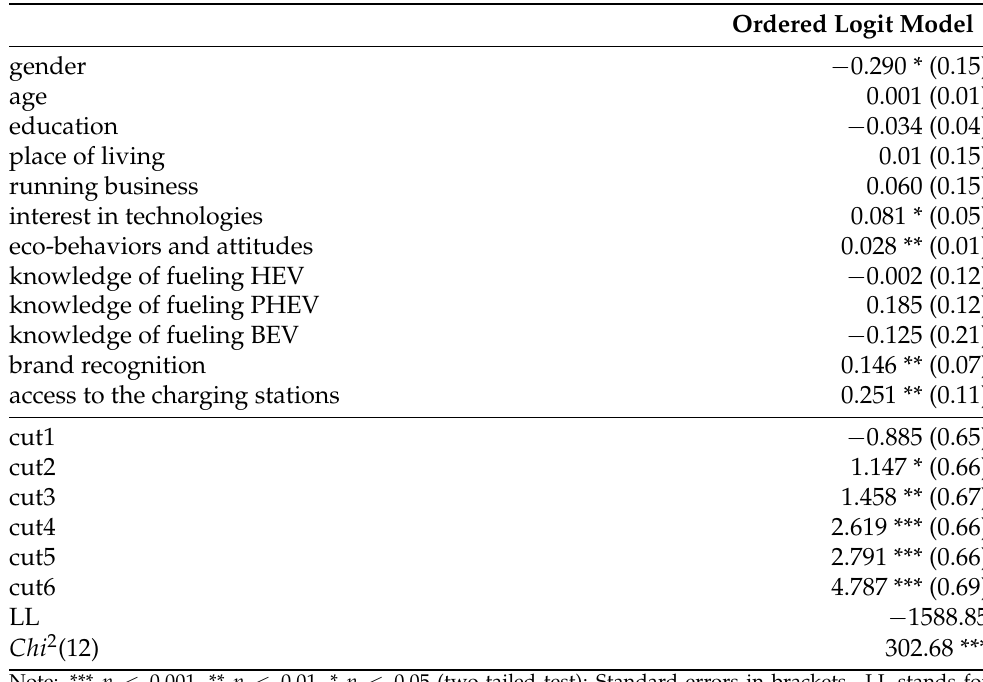
Table 4. Estimation results for the ordered logit model (N =